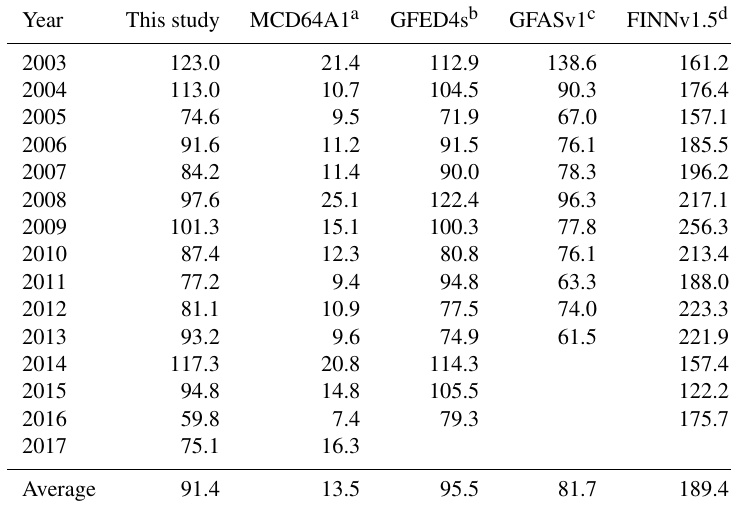
Table 3. Comparison of annual mean CO 2 emissions (Tg) from biomass burning calculated in our study with estimates made by other methods.